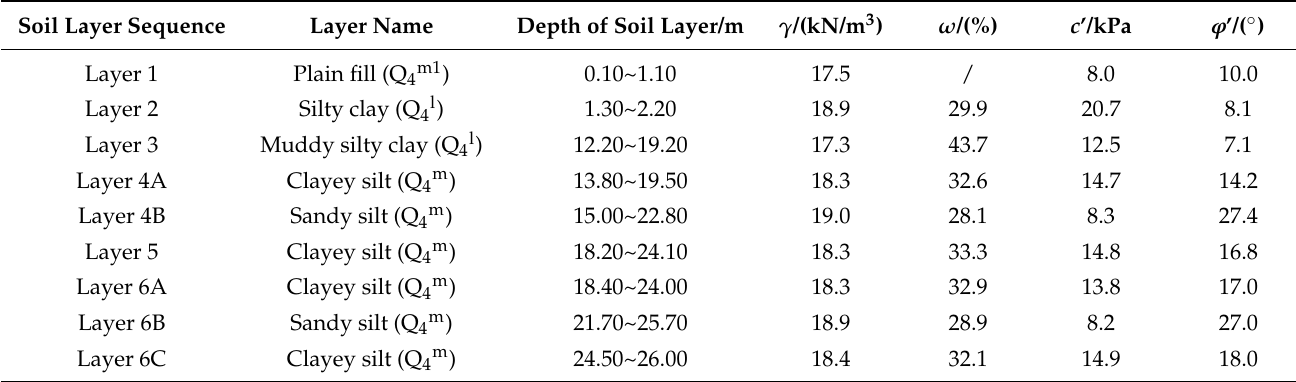
Table 1. Basic parameters of each rock and soil